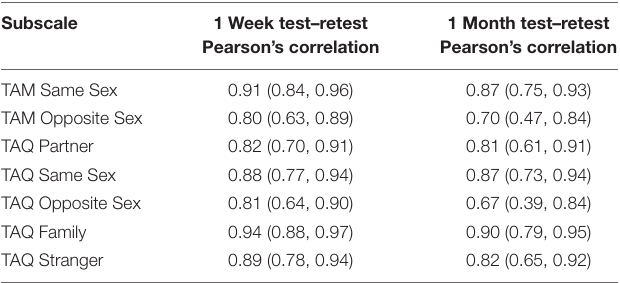
TABLE 4 | Test–retest correlation after 1 week and 1 month for all Touch Avoidance Measure (TAM) and Touch Avoidance Questionnaire (TAQ) subscales.